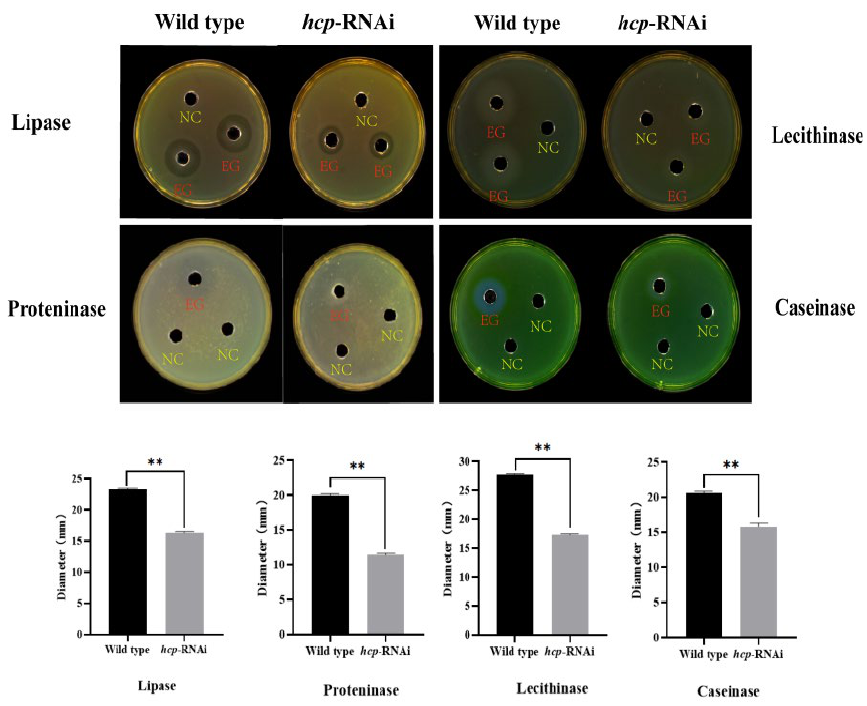
Figure 7. Effects of hcp gene silencing on the activity of extracellular enzymes of A. salmonicida . Note: NC—negative control; EG—experimental group. Data are presented as mean ± SD. Three independent biological replicates were performed per group. ** p < 0.01.